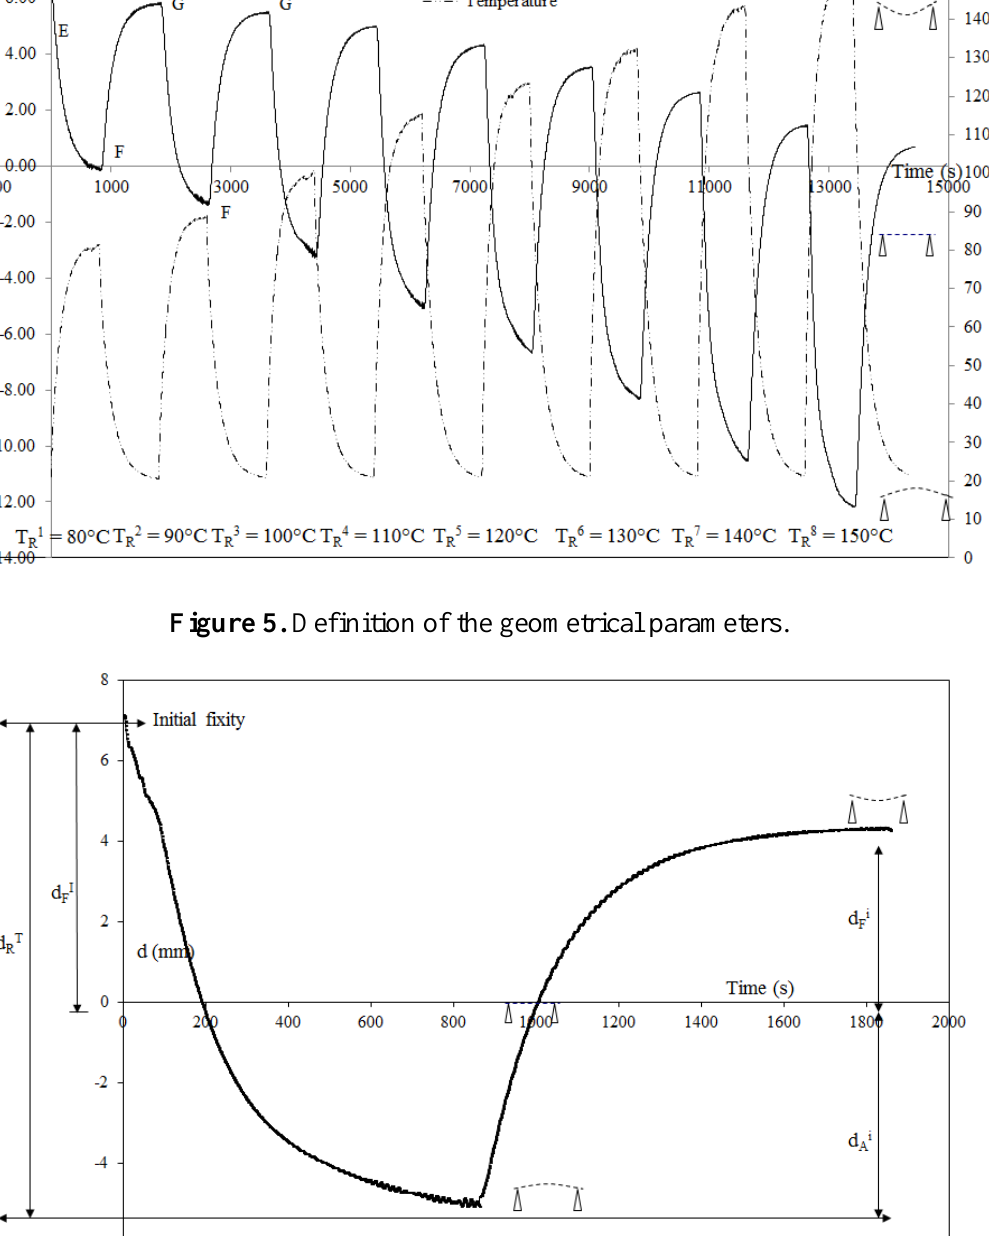
, FG: cooling to R